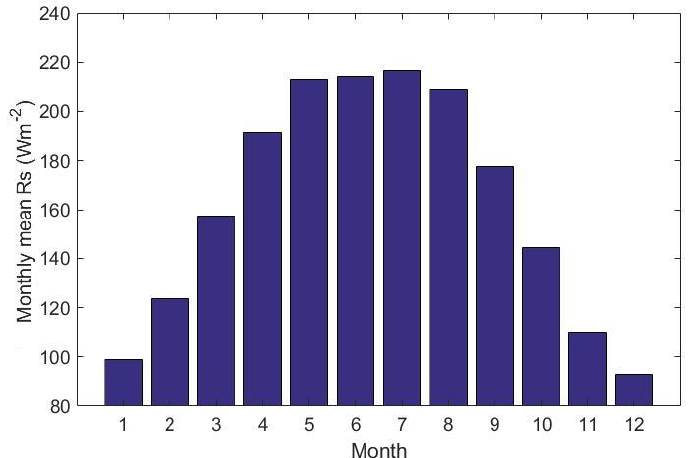
Figure 9. The monthly mean Rs over China during 1970–2015.